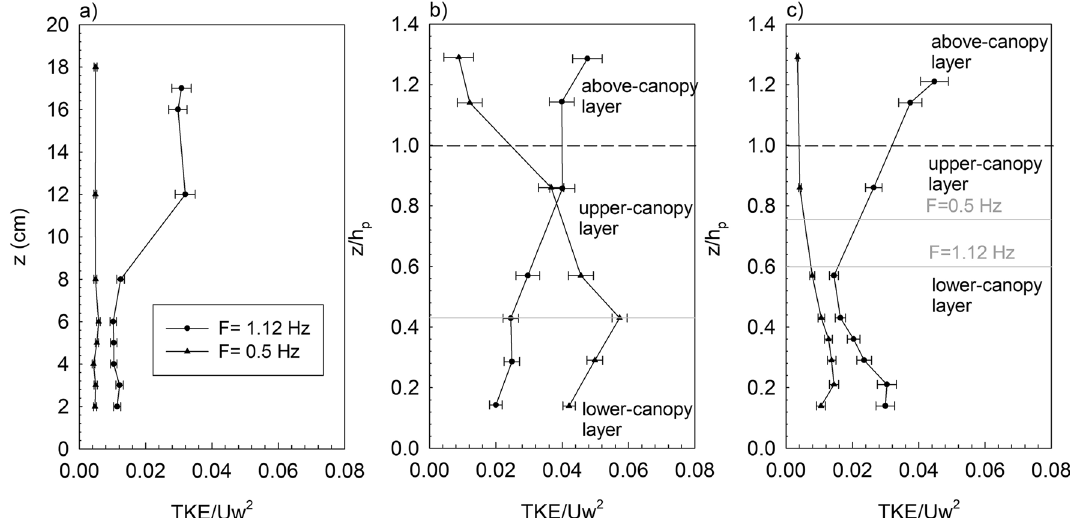
Figure 1. TKE/Uw 2 vertical profiles ( a ) versus z for non-vegetated set ups, and versus z/h p for ( b ) rigid vegetation and ( c ) flexible vegetation for the two wave frequencies studied f = 1.12 Hz (circles) and ( b ) f = 0.5 Hz (triangles). The horizontal dashed lines in ( b ) and ( c ) represent the height of the plant leaf for flexible plants ( h p ) or the height of the plant stem for rigid plants. The vegetated experiments presented here correspond to cases with a patch length of 238 cm and SPF = 10% . The horizontal grey lines represent the interface between the upper-canopy layer and the lower-canopy layer for both types of